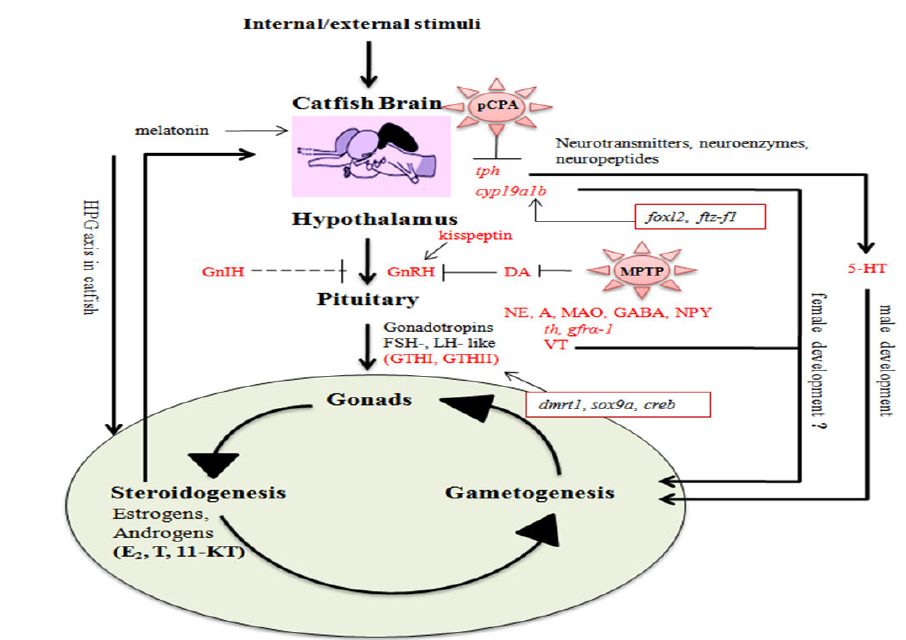
Figure 1. Schematic representation of neuroendocrine control of reproduction in